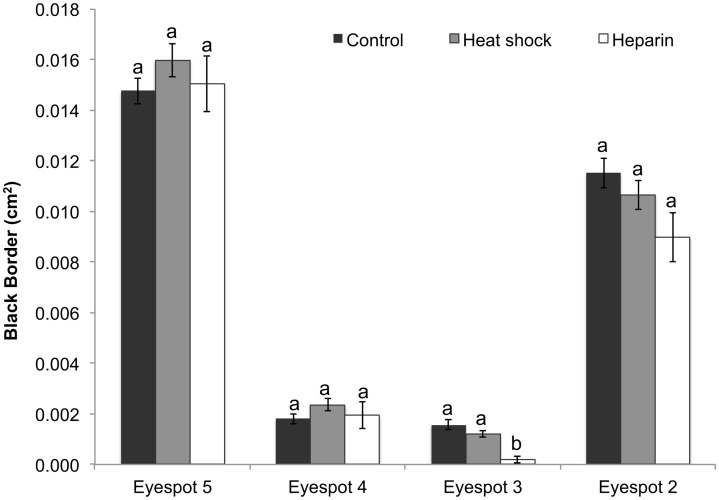
Area of the black border (outer ring) across all four eyespots in the different treatments.Data represent the area in cm2 with error bars representing 1 SE from the mean. The 2-way ANCOVA was performed on square-root transformed data. Results shown in Table 1. Different letters above the bars indicate significant differences within each individual eyespot.